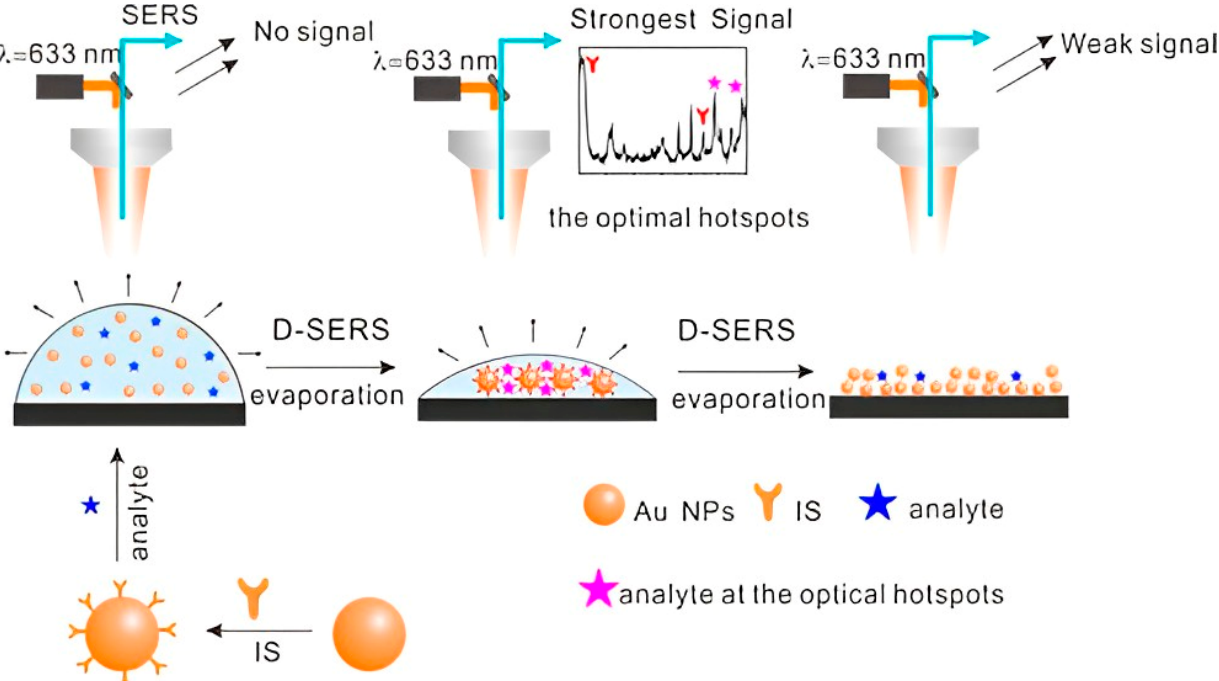
Figure 1. Schematic presentation of optimum hotspot formation during D-SERS, combined with the introduction of an internal standard for the detection of fentanyl. Sketches represent a drop of Au-sol, 3D hotspots, and aggregate of Au NPs, respectively [50].